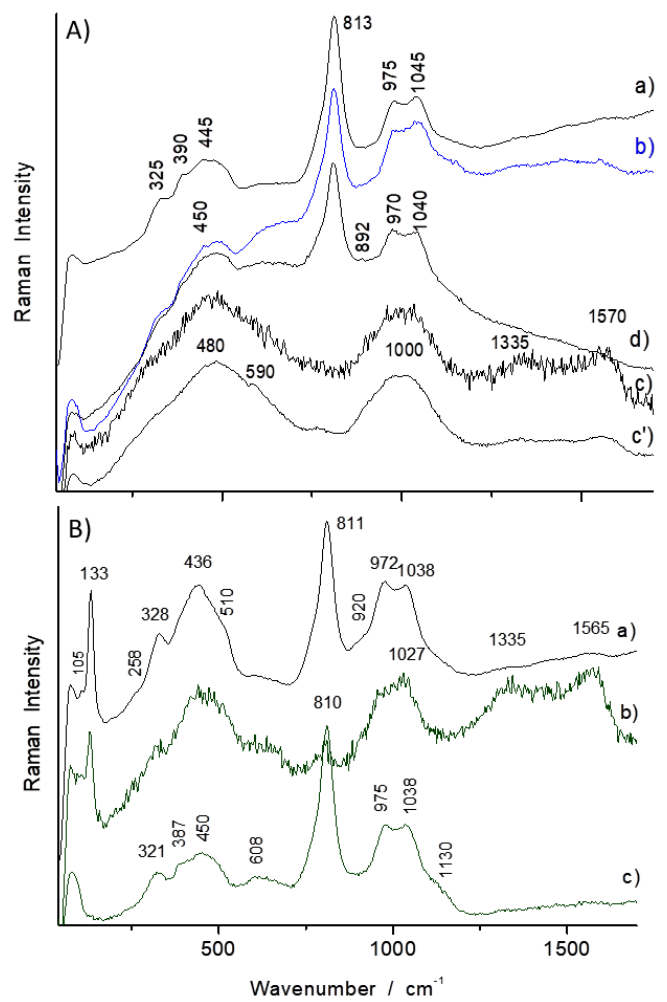
Figure 10. Representative Raman spectra recorded on the R975 bottle (2nd half of 18th century): ( A ) white (a), blue (b), pink (d) and black (c,c′) enamelled areas; ( B ) yellow (a,b) and green/turquoise (c) enamelled areas (noisy spectra are obtained with very short recording time to control that no change due to local heating takes place, except disappearance of carbon signal to some extent).